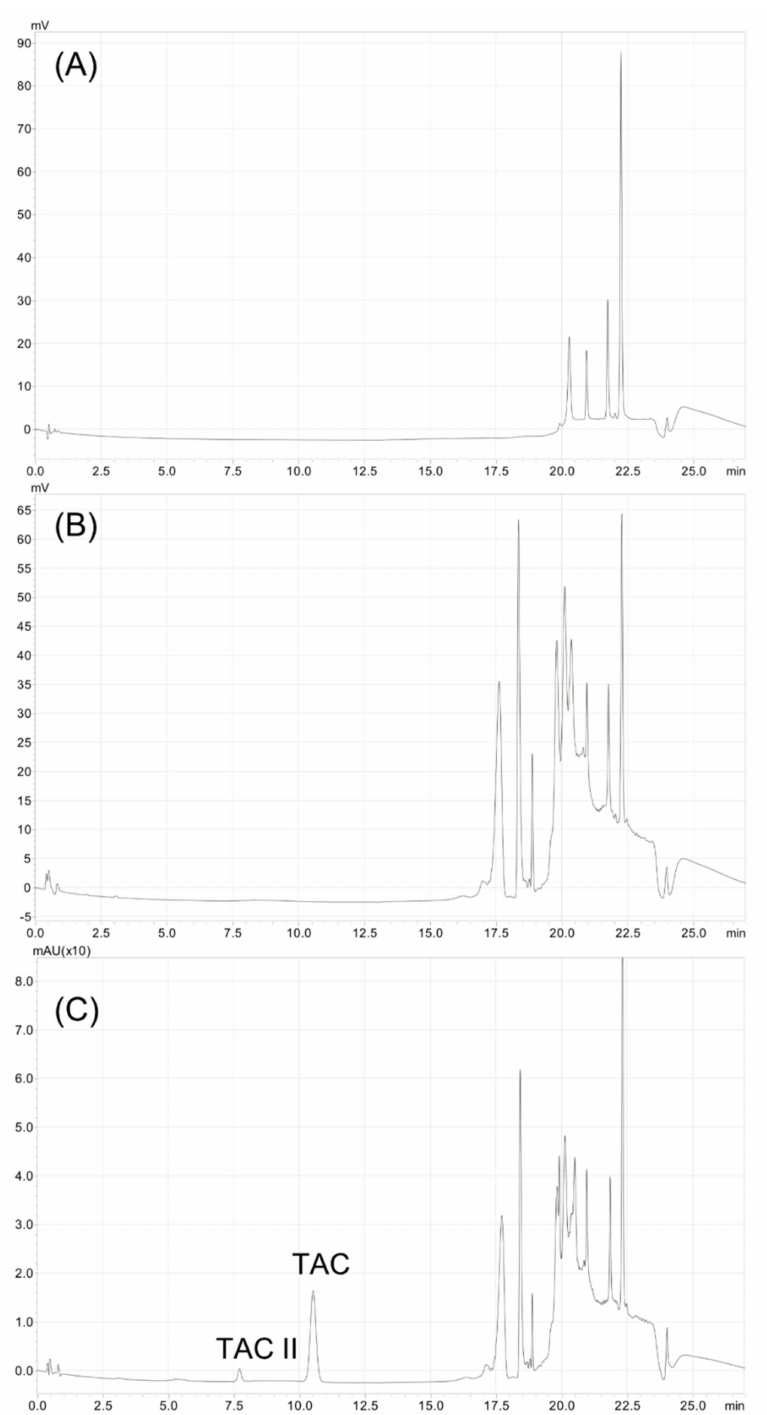
Figure 1. Chromatograms of ( A ) water blank, ( B ) Excipients (formulation without tacrolimus) diluted 1/20th and ( C ) 1 mg/mL tacrolimus formulation diluted 1/20th to 50 µ g/mL in acetonitrile-water (70:30, v/v ). TAC: tacrolimus. TAC II: tacrolimus compound II (equilibrium